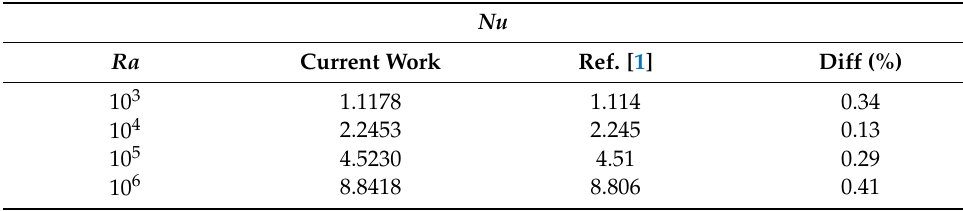
Table 1. Comparison of average Nusselt numbers for different Rayleigh numbers.